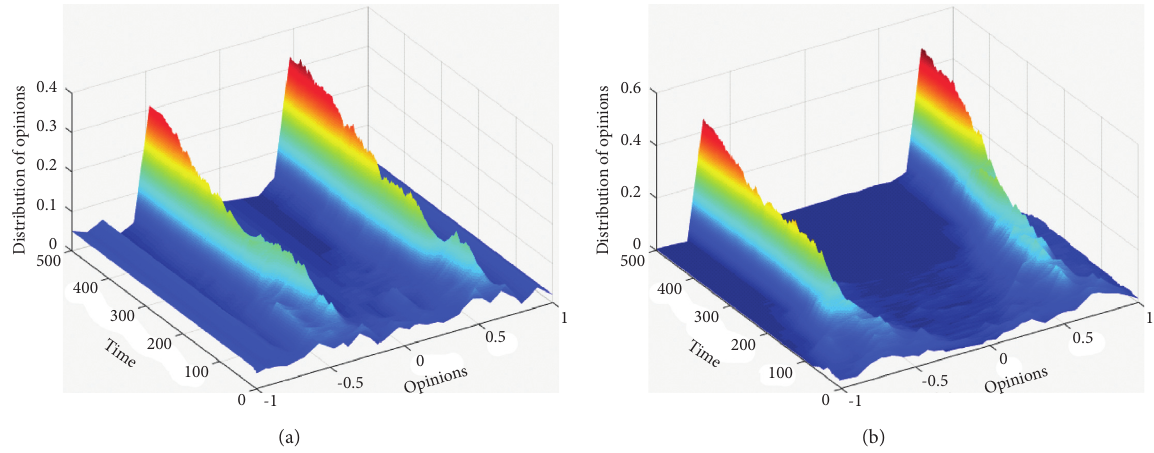
Figure 11: Two opinion leaders with opposite opinion values. There are two opinion clusters when d two clusters are close to 0.5 and − 0.5, respectively; there are two opinion clusters when d m � 0 . 9; the opinion values of these two clusters are close to 0.8 and − 0.8, respectively. (a) d m � 0 . 45. (b) d m � 0 .